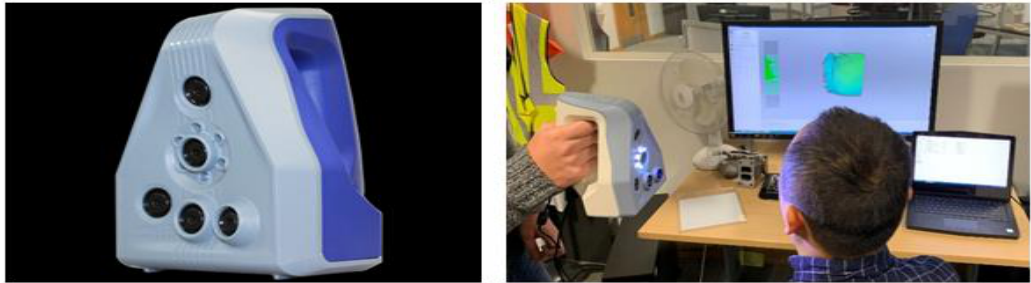
Figure 3. Scanning tool.